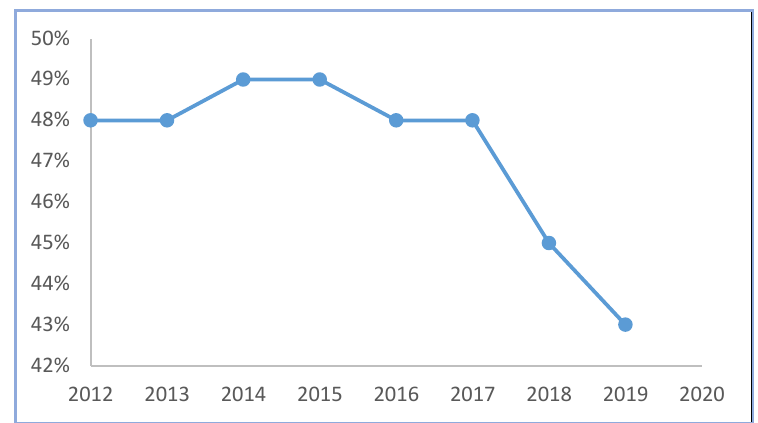
Figure 1. High School Student STEM Interest From ACT CCCR